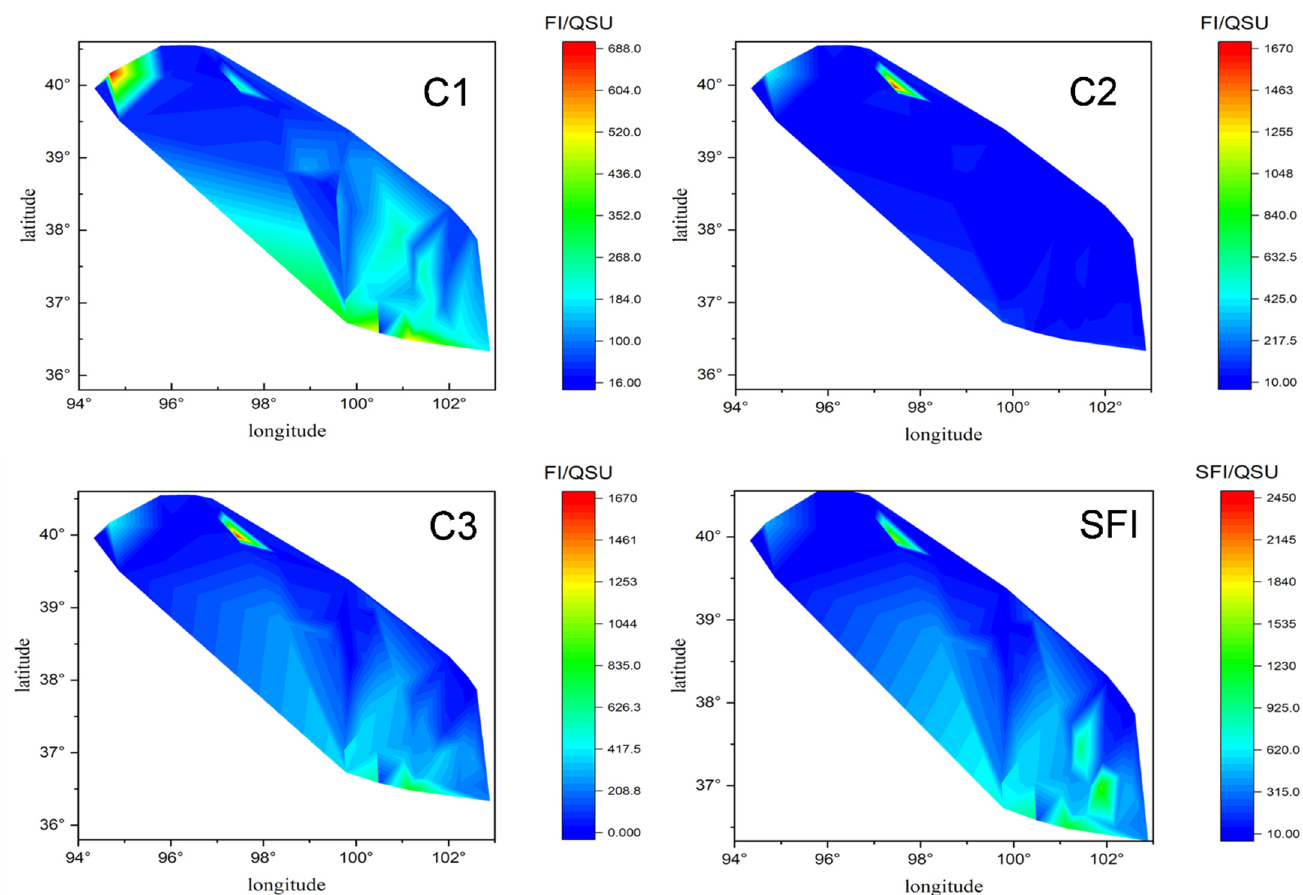
Figure 2. Spatial distribution of three fluorescent components along with the sampling transect (SFI: Sum of fluorescent intensity).